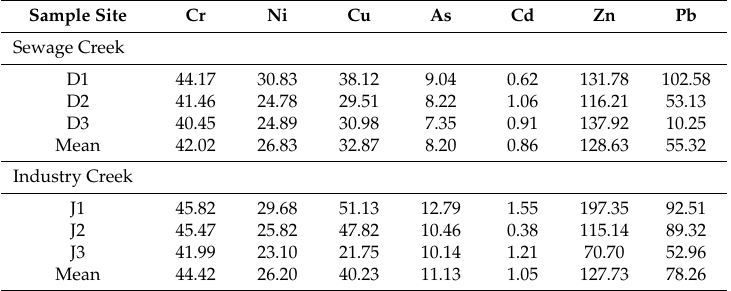
Table 4. Content of heavy metals in the creek sediments (mg/kg).